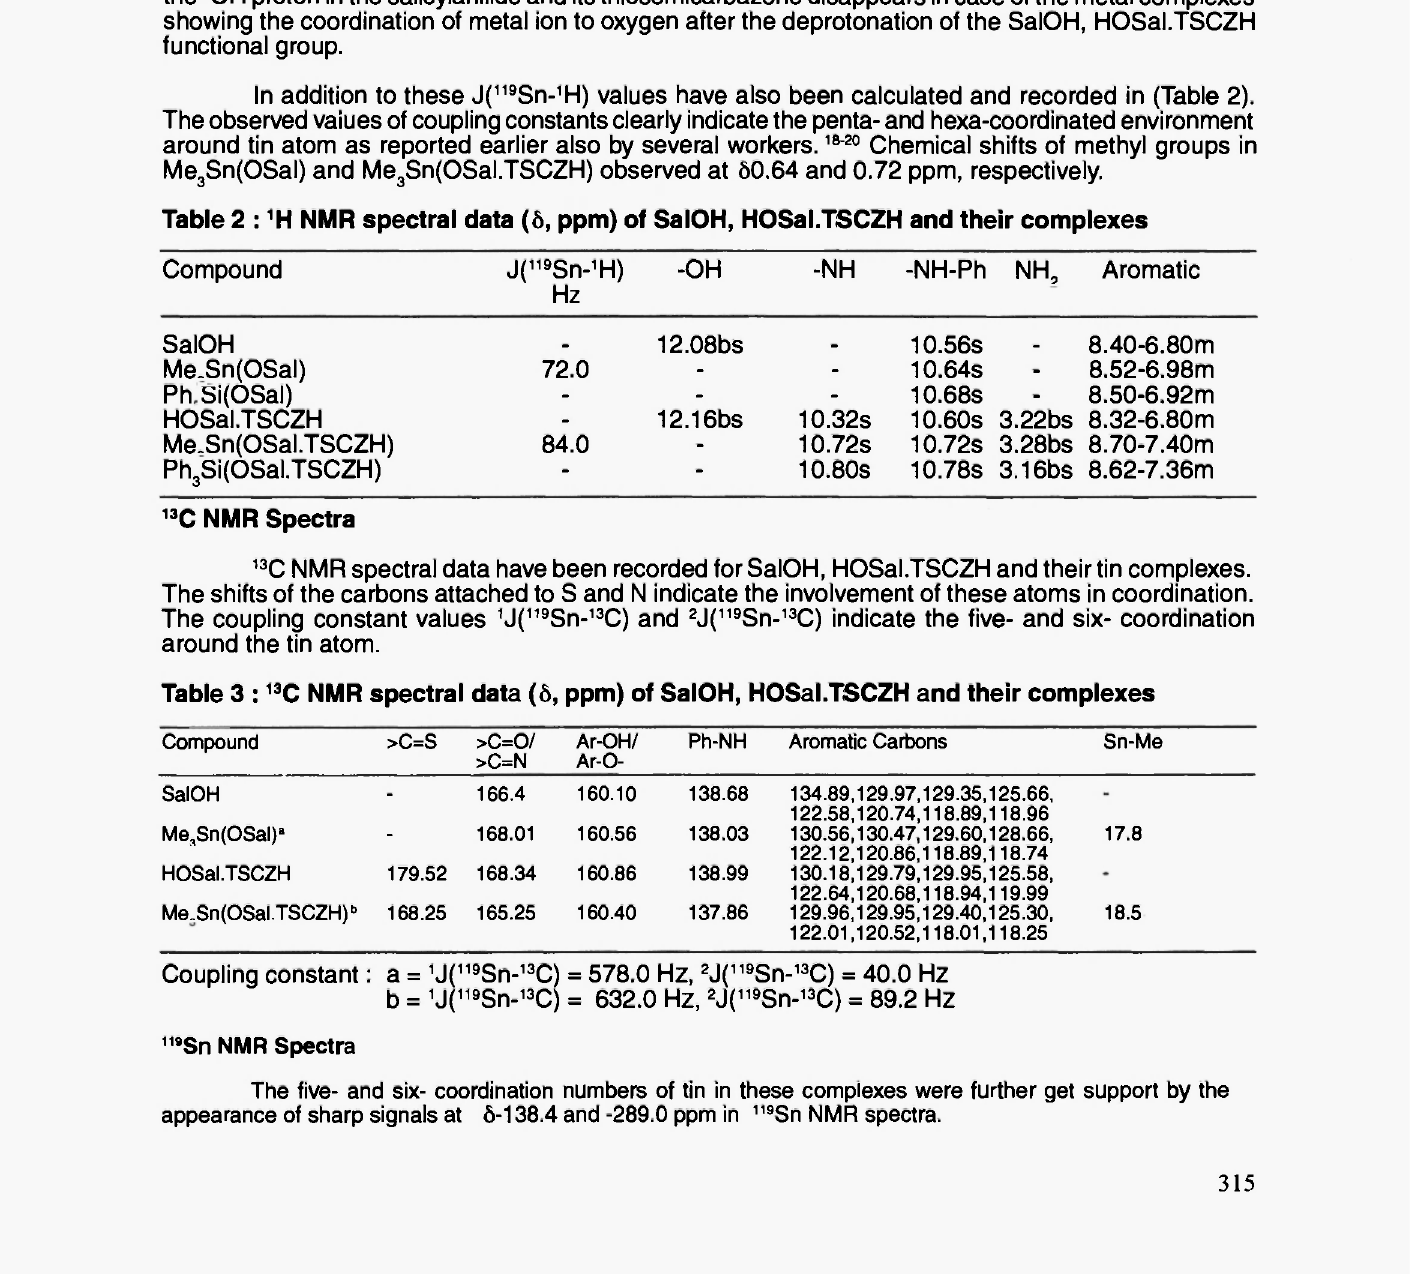
Table 2 : 1 H NMR spectral data (δ, ppm) of SalOH, HOSal.TSCZH and their complexes Compound